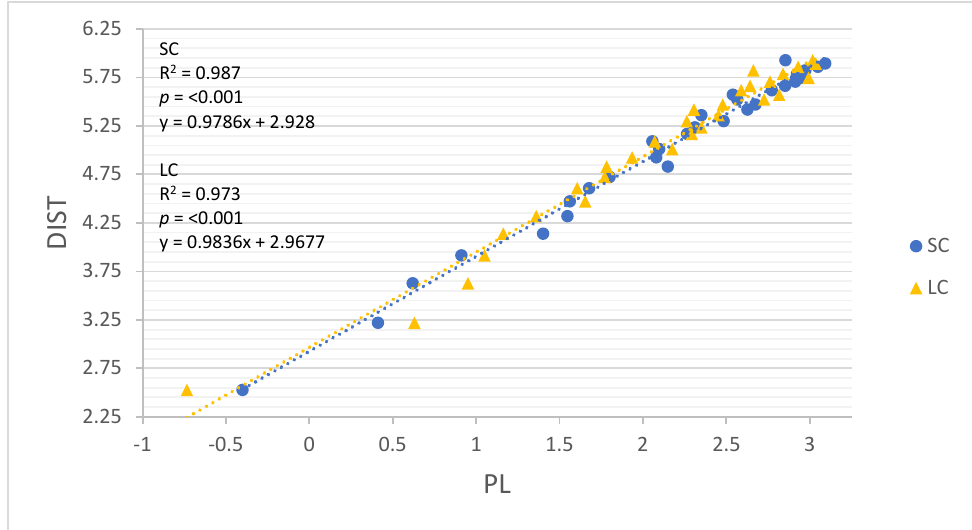
Figure 6. The relationship between log transformed DIST and PL around the small circle and the large circle. SC = small circle, LC = large circle. Table 5. Details for each trial include laps and known distance completed around the small circle course, GNSS measured distance, and all accelerometry derived metrics.